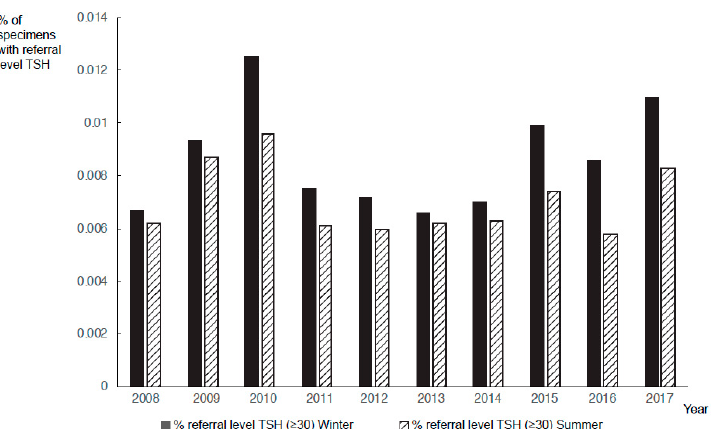
Figure 4. Percentage of specimens with referral-level TSH ( ≥ 30 μ U/mL) from 2008–17 excluding specimens collected <24 h after birth. Black bars represent percentage of specimens with referral-level TSH values in the winter, and hatched lines represent percentage of specimens with referral level TSH values in the summer.